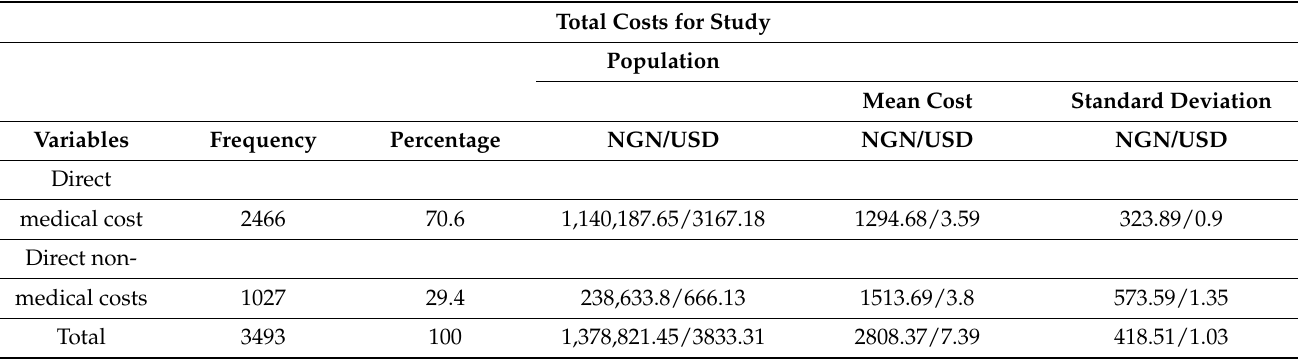
Table 4. Direct average and total costs per case of uncomplicated malaria on respondents in